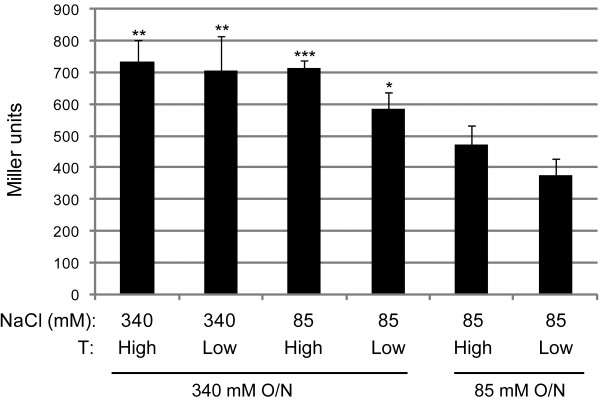
The influence of salt and temperature on the VipA-VipB interaction. The VipA-VipB interaction in the reporter strain KDZif1ΔZ leads to β-galactosidase activity, which is influenced by the growth temperature as well as the NaCl concentration of the medium. Shown is the mean β-galactosidase activity ± standard deviation in Miller units produced from two experiments where two independent transformants were tested on each occasion. The temperatures tested were 37°C (High) or 23°C (Low). Data was subjected to a student’s 2-sided t-test to determine whether the β-galactosidase activity produced at any given condition was significantly different from that produced by KDZif1ΔZ grown under standard assay conditions (85 mM NaCl, 37°C) (*, P < 0.05; **, P < 0.01; ***, P < 0.001).